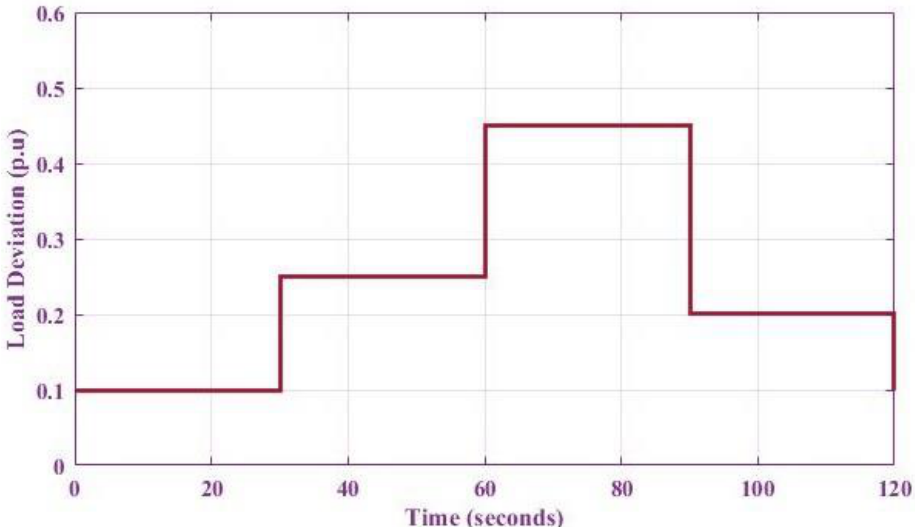
Figure 12. Abrupt load deviation presentation.